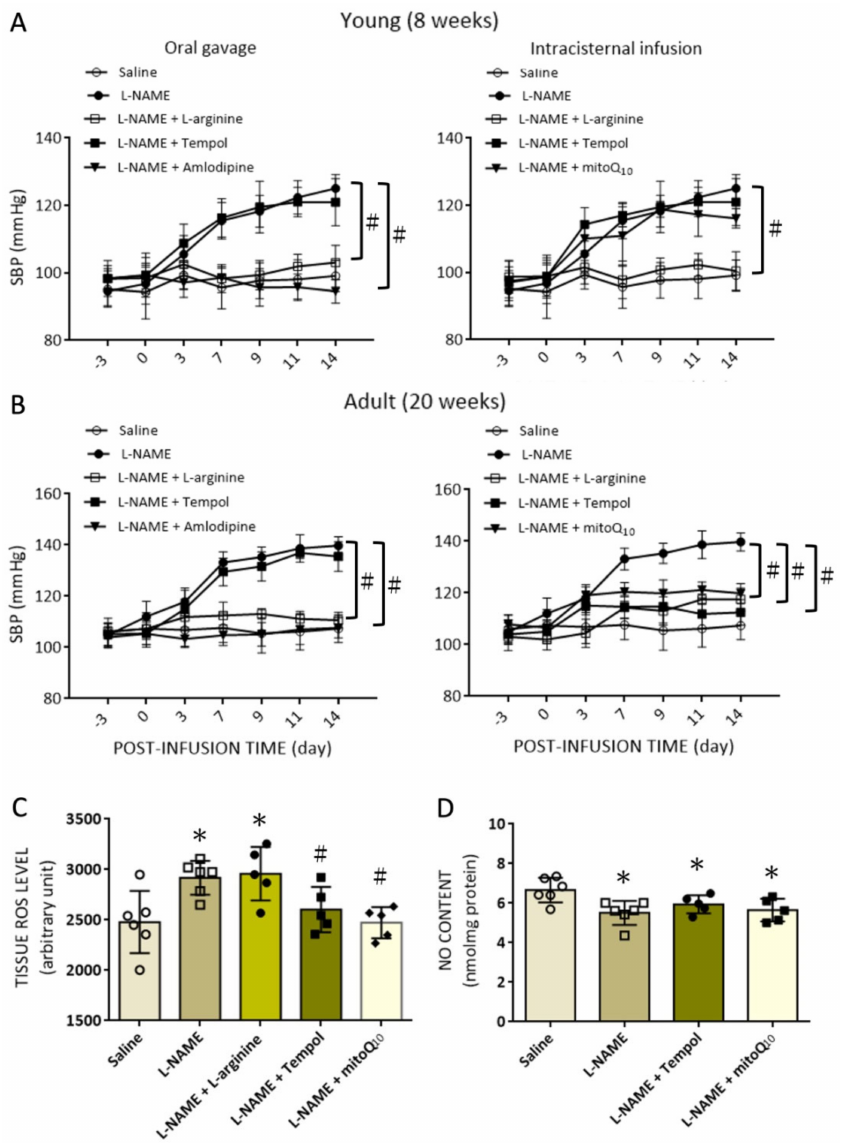
Figure 6. Effect of NO donor and antioxidants on changes in SBP, and tissue ROS and NO levels in RVLM of young and adult rats induced by systemic L -NAME treatment. Temporal changes in SBP at different postinfusion time points after i.p. infusion of L -NAME, alone or with additional oral intake or i.c. infusion of various pharmacological treatments in young ( A ) and ( B ) adult rats. Also shown are tissue levels of ROS ( C ) and NO ( D ) in RVLM, measured at day 14 after i.p. infusion of L -NAME, alone or with additional i.c. infusion of pharmacological treatments. The pharmacological treatments included i.p. infusion of L -NAME (10 mg/kg/day), oral intake via gavage of L-arginine (2%), tempol (100 µ mol/kg) or amlodipine (10 mg/kg), or i.c. infusion of L-arginine (2 µ g/kg/day), tempol (1 µ mol//h/ µ L), or mitoQ 10 (2.5 µ mol//h/ µ L). Control infusion of 0.9% saline (for i.p. or oral gavage treatment) or artificial CSF (aCSF; for i.c. infusion) served as the volume and vehicle control. Data are presented as mean ± SD, n = 5–6 per group, and * p < 0.05 versus the corresponding saline- treated group, and # p < 0.05 versus the L -NAME group in post hoc Tukey’s multiple comparisons tests or unpaired Student’s t -test. Data on saline and L -NAME treatments from Figure 2 are adopted for